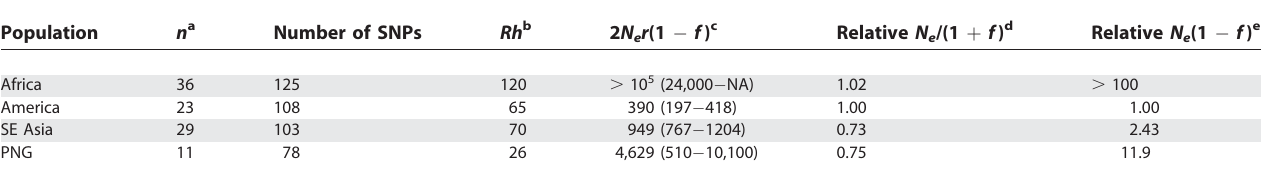
Table 2. Population Recombination Rate Variation on Chromosome 3 among P. falciparum Populations Population